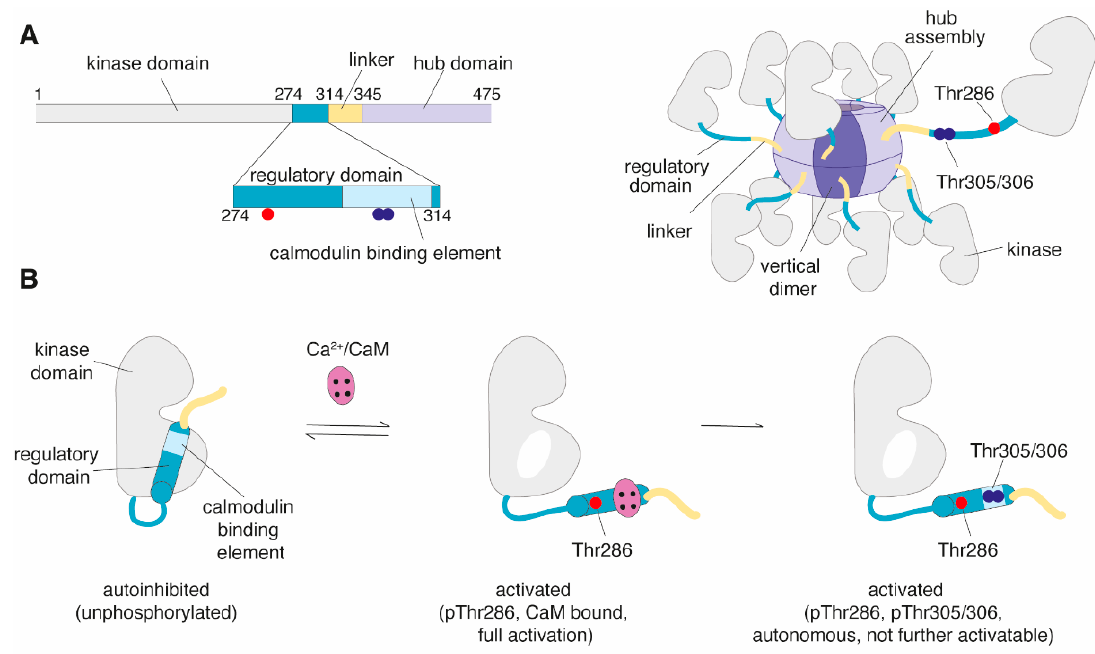
Figure 1. Structure and activation of Ca 2+ /calmodulin-dependent protein kinase II (CaMKII) [32,41]. ( A ) (Left) Domains of individual CaMKII subunit: kinase (grey), regulatory (teal), linker (yellow) and hub (purple) domain. The regulatory domain contains important autophosphorylation sites Thr286 (red) and Thr305/306 (blue). Thr305/306 are located within the calmodulin binding element (light blue). (Right) Holoenzyme assembly made up of 12 subunits. ( B ) Regulation of CaMKII activity. Of note, the hub domain is not shown. During basal states, the regulatory domain binds to the kinase domain and blocks access to the substrate binding site (autoinhibition). CaMKII gets activated